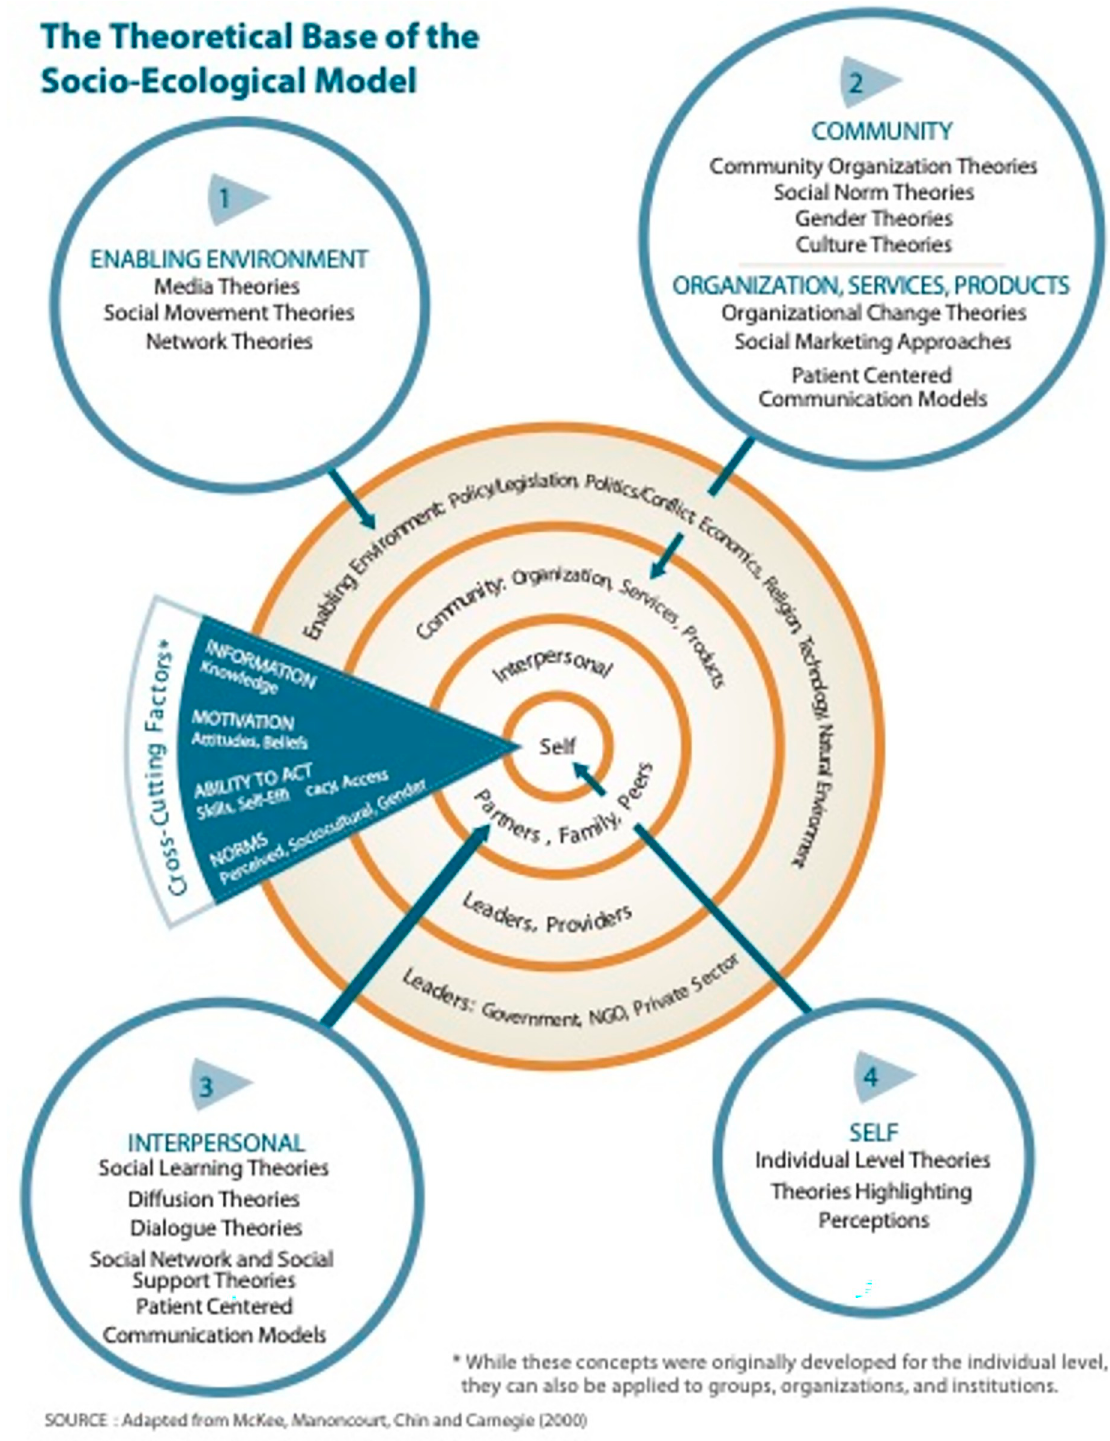
Fig 1. The Theoretical Base of the Socio-Ecological Model C-Change. Use authorized by FHI 360. Original source: C-Change . 2012 . C-Modules : A Learning Package for Social and Behavior Change Communication (SBCC) . Washington , DC : C-Change/FHI 360 .